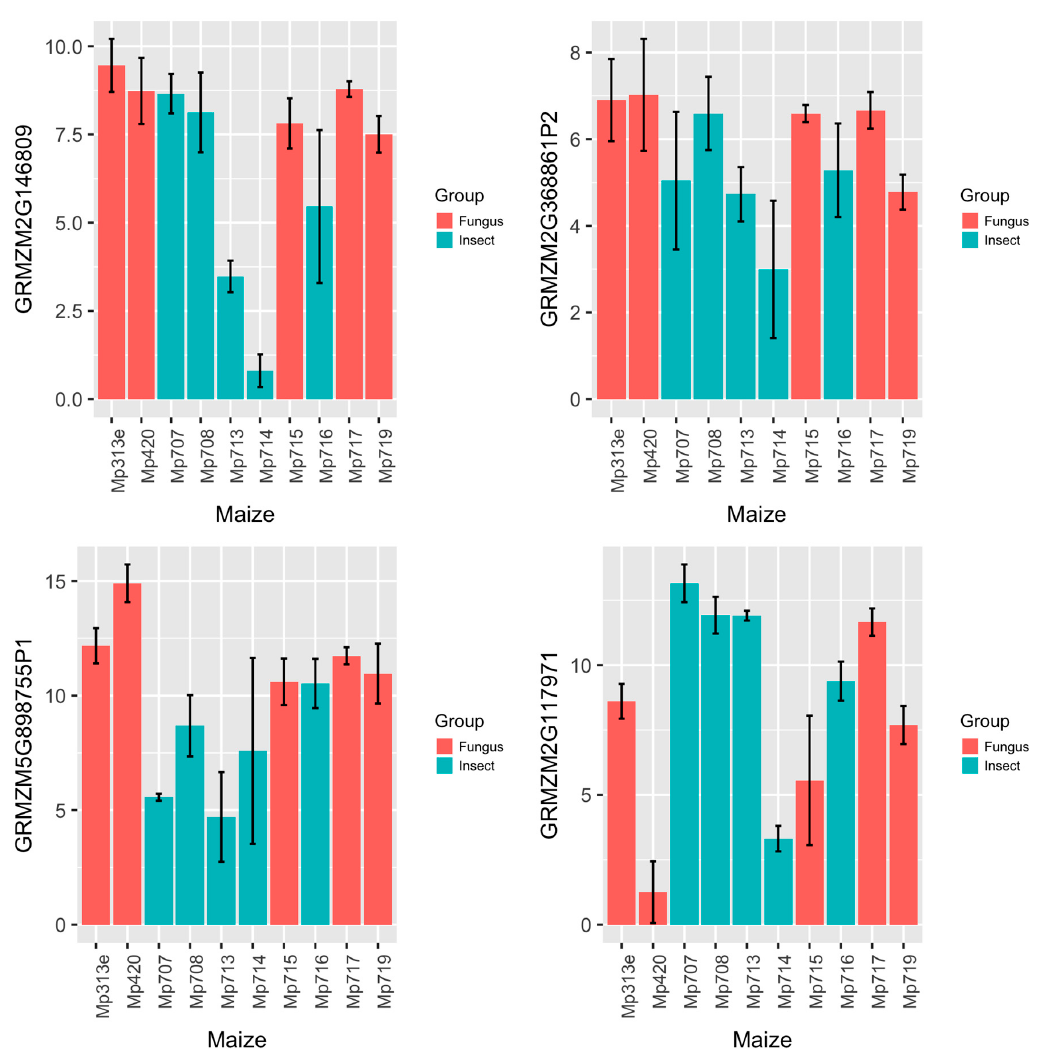
Figure 4. Bar graphs showing the relative gene expression levels in maize inbred lines that grouped by fungus resistance or insect resistance. The qRT-PCR data revealed variations in gene expression levels of the maize AMPs with distinct maize fungus and insect resistance groups. The expression of GRMZM2G146809 (a defensin on maize chromosome 10) reveals a dichotomy between the two sets of maize inbred lines. Relative Expression of Lipid Transfer Protein GRMZM5G898755 (located on maize chromosome 10) displayed significant variations across the 10 maize inbred lines. The relative expression of GRMZM2G368861 (located on maize chromosome 10) showed similar patterns associated with fungal resistance. Expression of maize Hevein GRMZM2G117971 (on maize chromosome 4) varied greatly across the 10 maize inbred lines and averaged higher in expression associated with insect resistance.